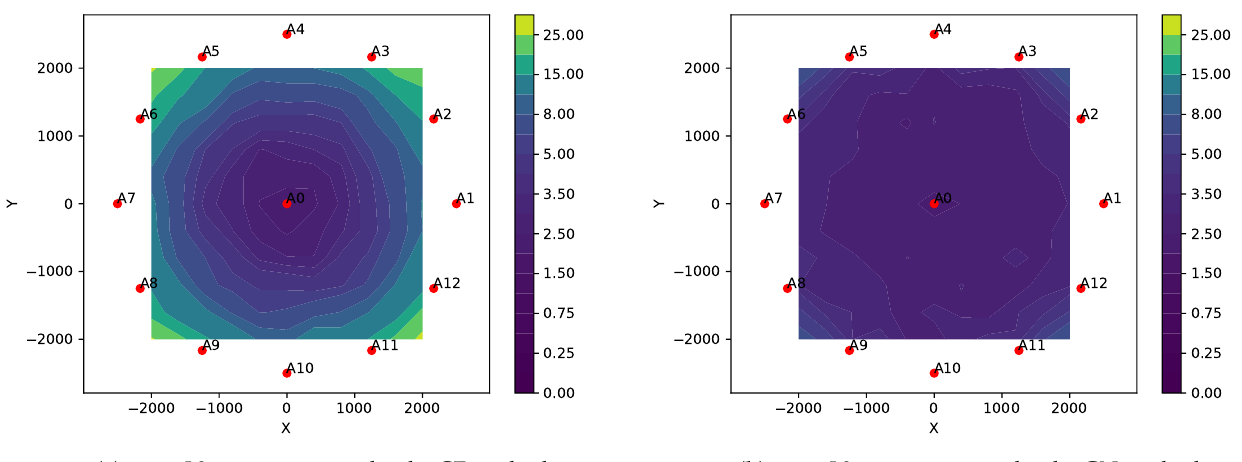
Contour of Mean L2-Errors: Selected Anchors in Red